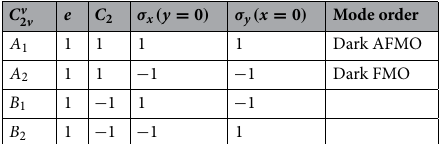
Table 2. IRREPs of group C 2 v , mode order.